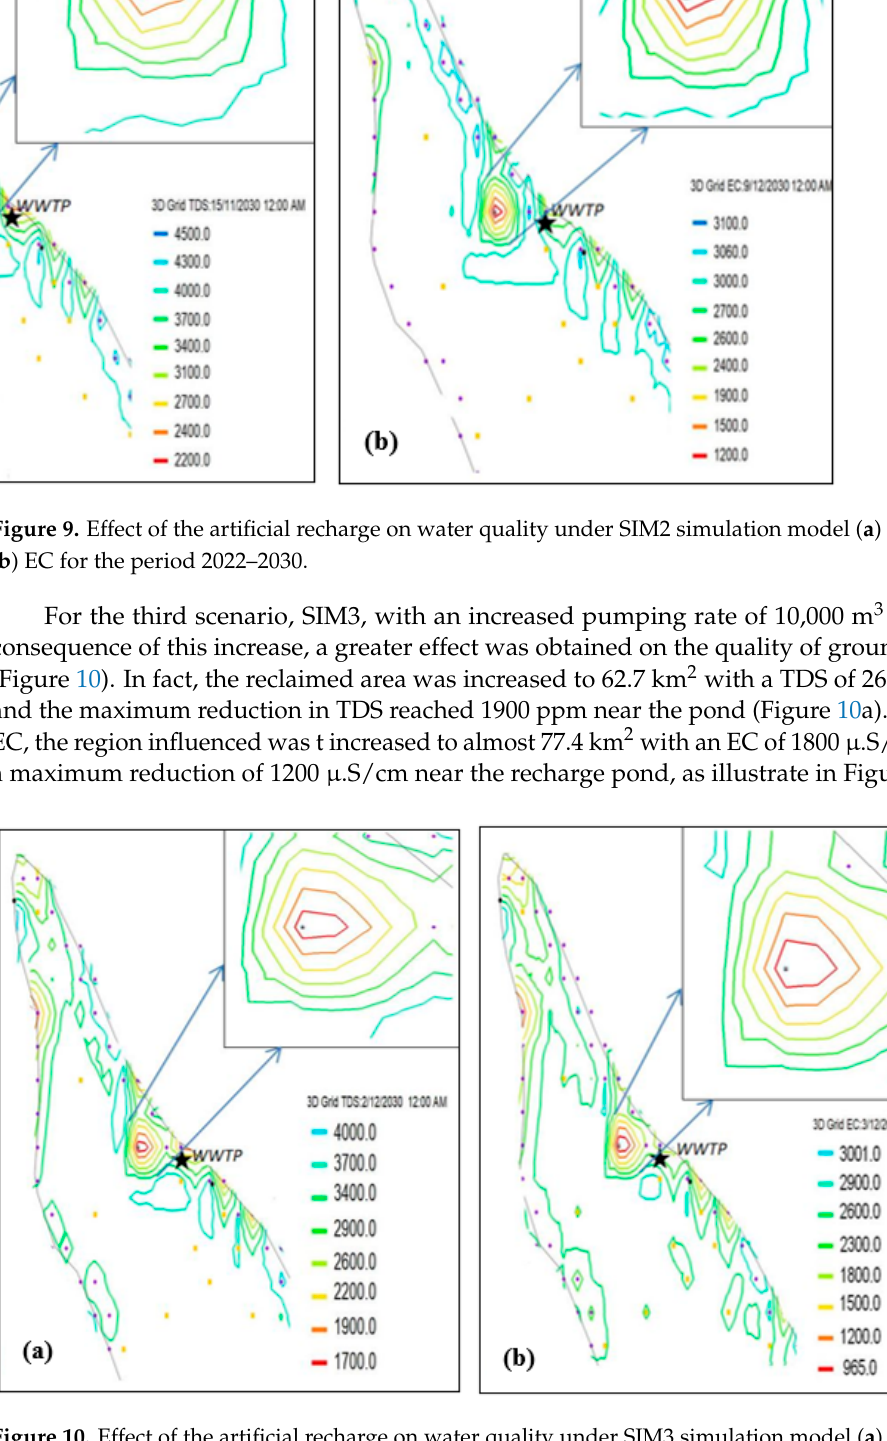
Figure 10. Effect of the artificial recharge on water quality under SIM3 simulation model ( a ) TDS and ( b ) EC for the period 2022–2030. ( b ) EC for the period